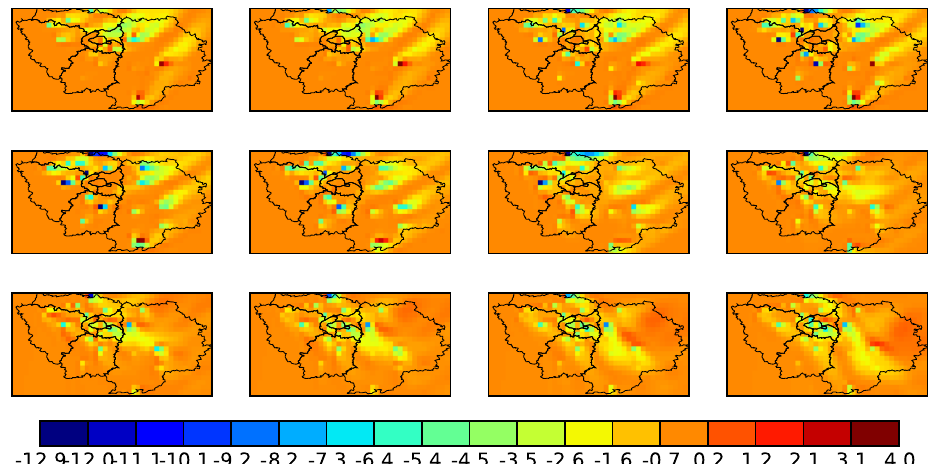
Fig. 10. Evolution of the difference between reference and plume-in-grid NO ground concentrations during twelve hours, from 23 August at 03:00 (local hour) to 23 August at 14:00. Unit is µgm − 3 . Plume-in-grid concentrations are subtracted to the reference concentrations.